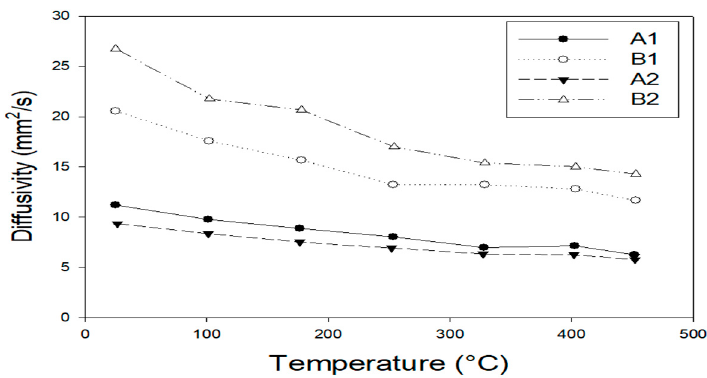
Figure 8. Diffusivity as a function of temperature for A1, B1, A2, and B2.